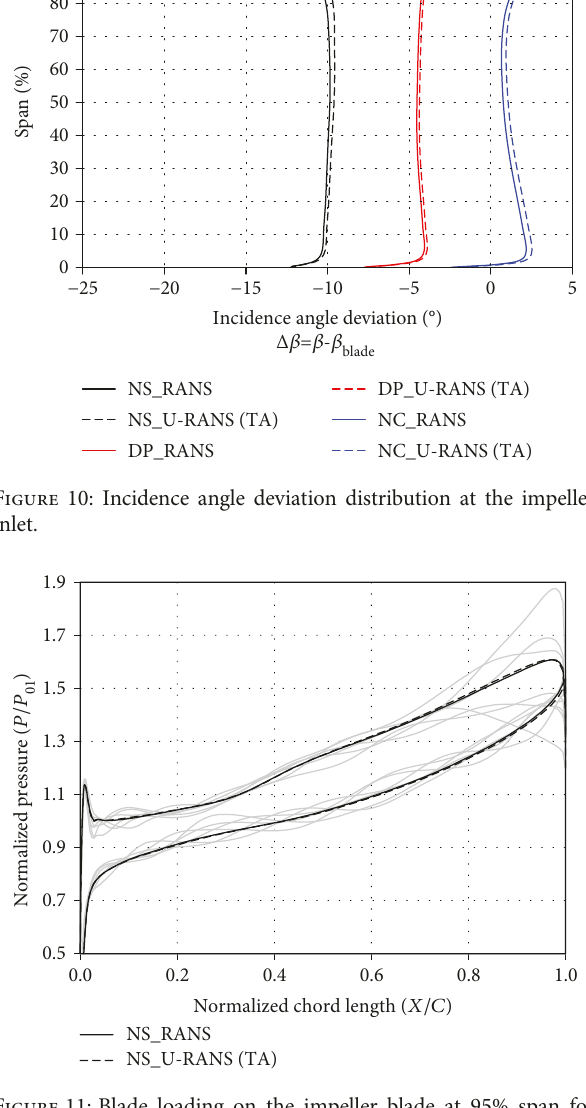
Figure 11: Blade loading on the impeller blade at 95% span for the